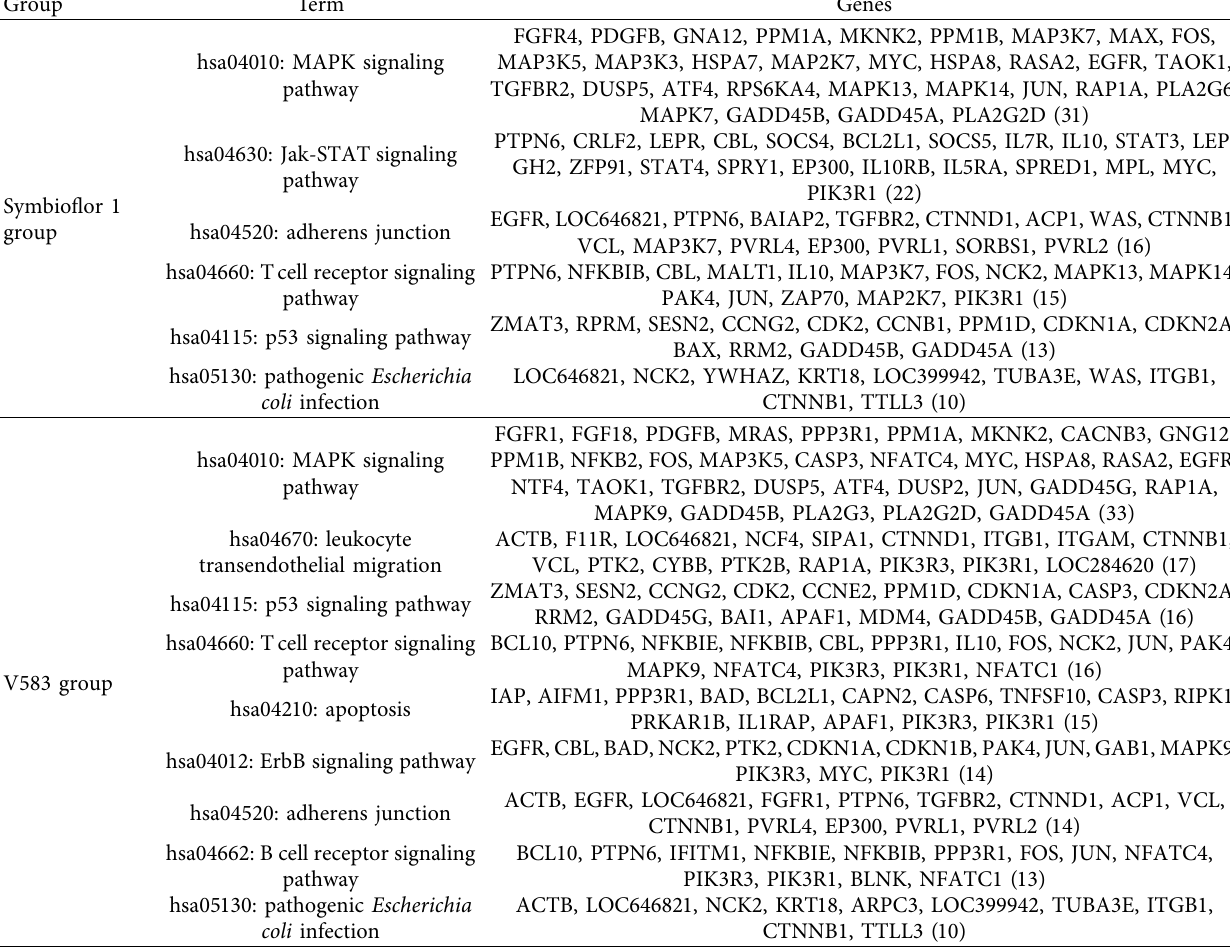
Figure 2: Distribution of DEGs of BeWo cells in response to different E. faecalis strains. Venn diagram showing the number of unique and common DEGs in BeWo cells in response to Symbioflor 1 and V583 infection. (a) Total DEGs; (b) upregulated genes; (c) downregulated Table 2: DEGs containing relevant terms of the signal pathway generated by KEGG pathway analysis. Group